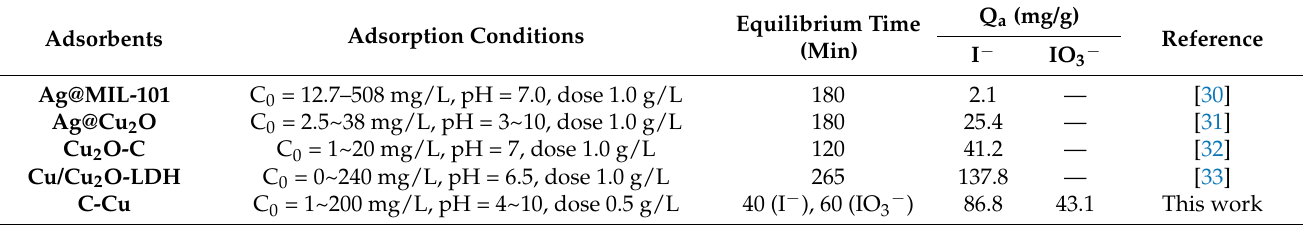
Table 4. Iodide ion removal performance parameters of different